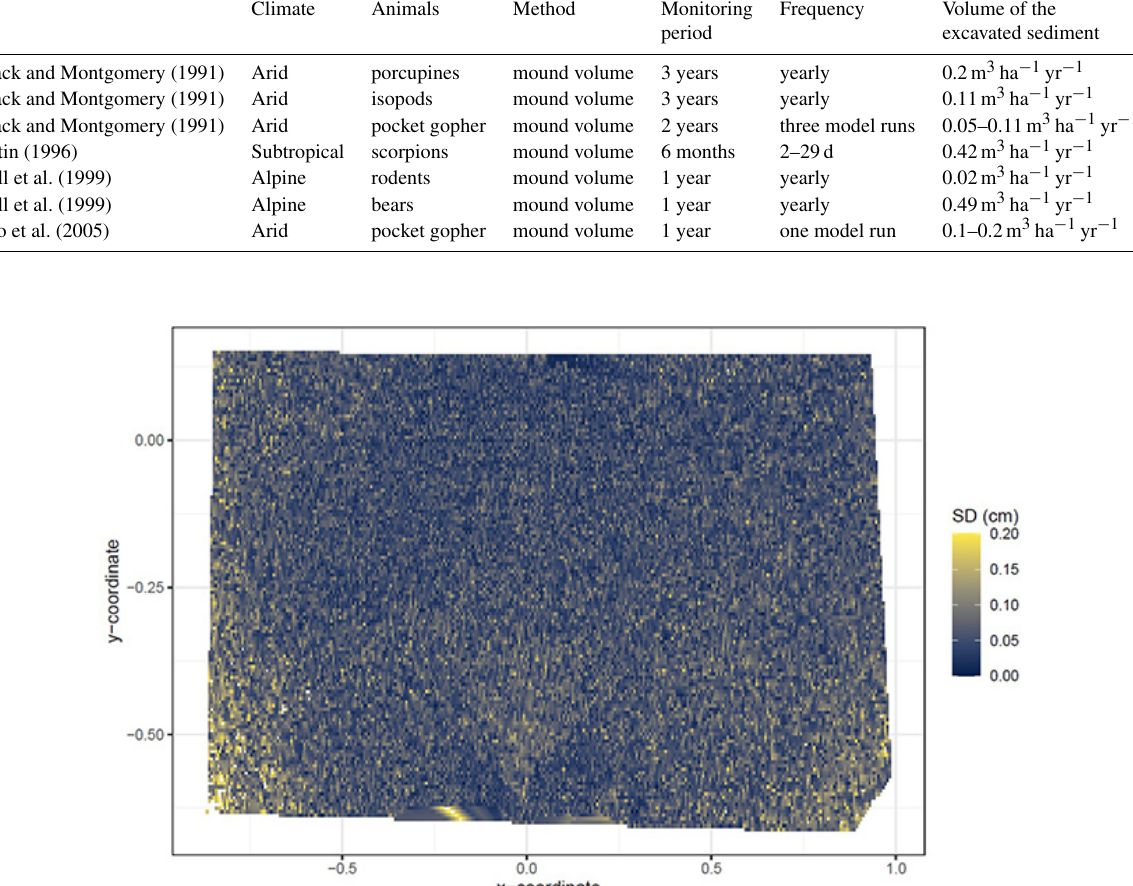
Figure A1. Standard deviation of the z coordinate of five unprocessed scans shown for the camera on the north-facing upper hillslope. SD is standard deviation. The error increases with distance from the camera nadir point. The standard deviation was calculated from the scans before any